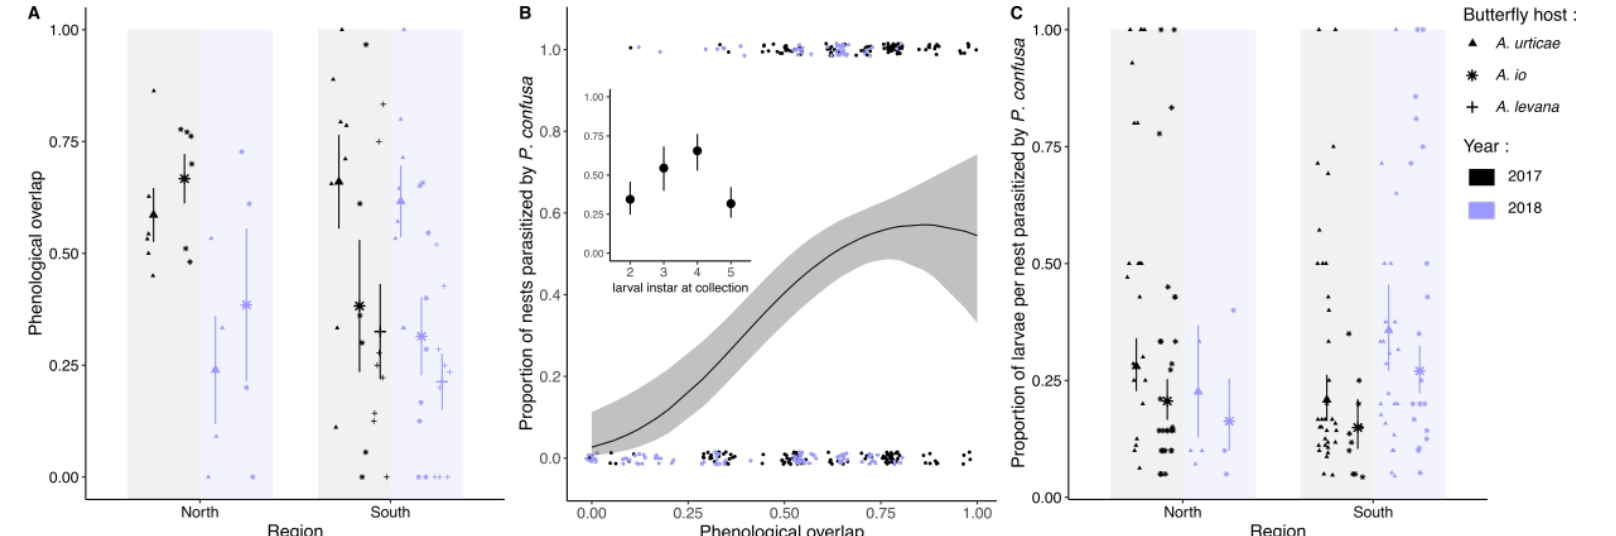
Figure 2. ( A ) Phenological overlap between P. confusa and its hosts butterflies, A. urticae , A. io , and A. levana , according to year and region; ( B ) jittered dots representing the proportion of nests of A. urticae and A. io parasitized according to the phenological overlap and larval instar at collection; ( C ) the proportion of larvae parasitized by P. confusa per nest for A. urticae and A. io according to year and region. Dots represent the raw data, means ± confidence intervals. In purple are the data for 2018, in black for 2017. The shape of the dots in ( A ) and ( C ) refer to butterfly host species (see ( C ),